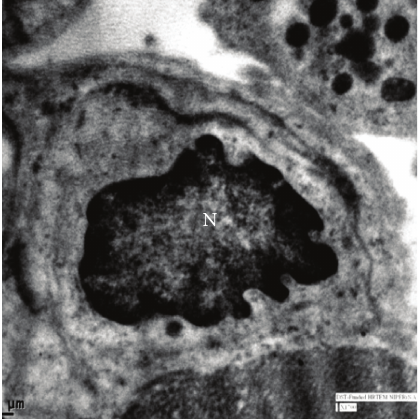
Figure9:48 cmCVRL(182days)showingintralobularduct(INLD) and acini (A). Hematoxylin and eosin × 400.